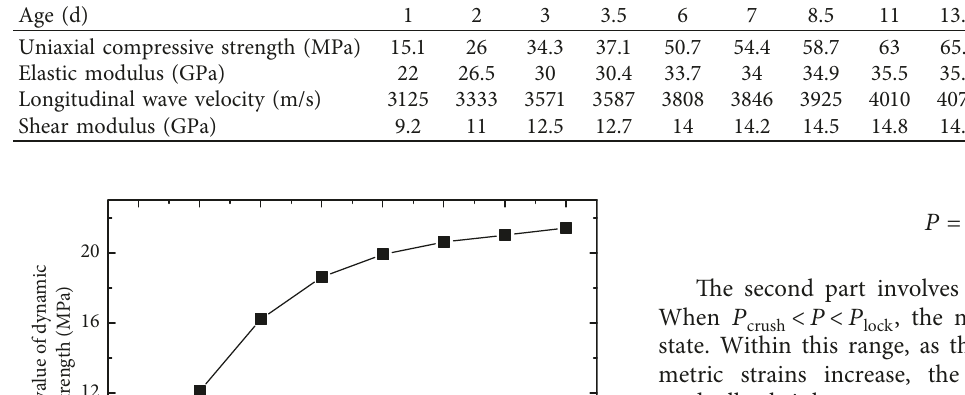
Table 2: Mechanical parameters of C65 concrete test blocks of different ages.